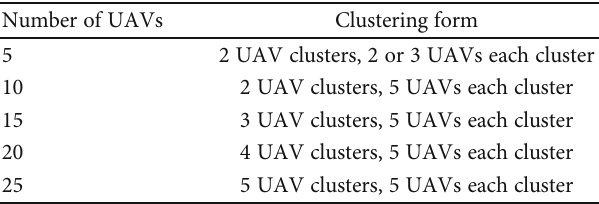
Table 8: The clustering form of the two-layer algorithm. Number of UAVs